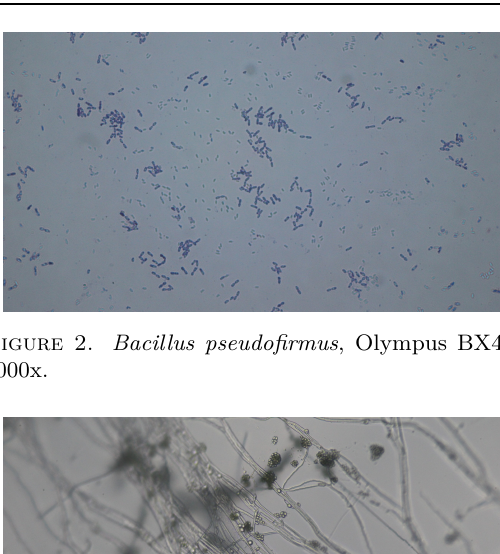
solution on the 2